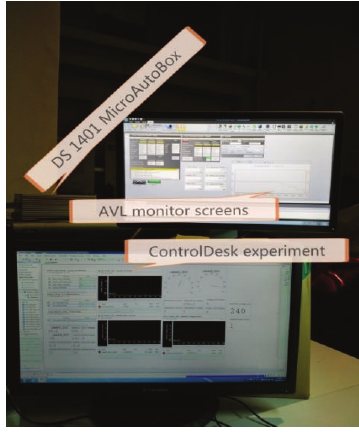
Figure 14: Software control system.